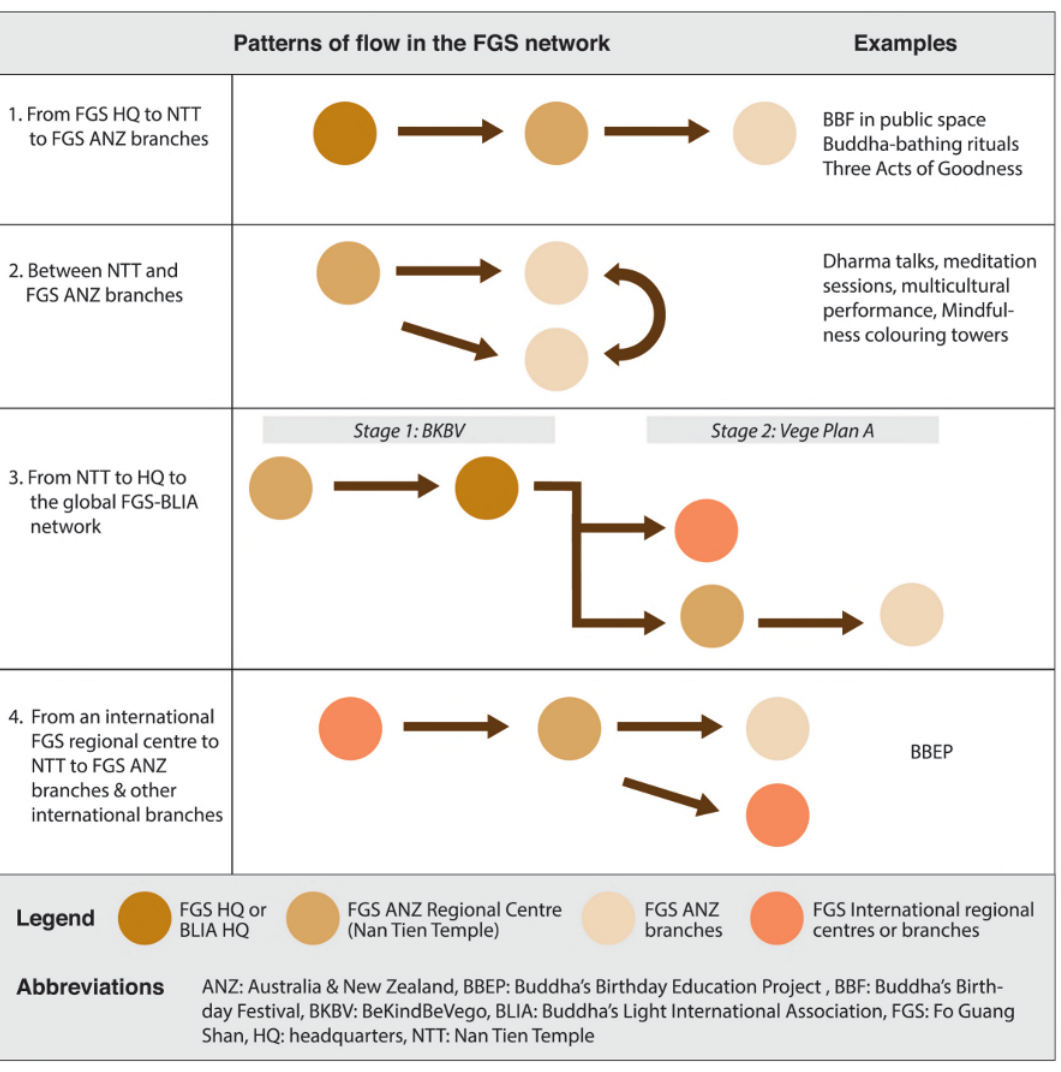
Figure 2: The four different flow patterns of innovations in the Fo Guang Shan (FGS) network and their examples as used in this